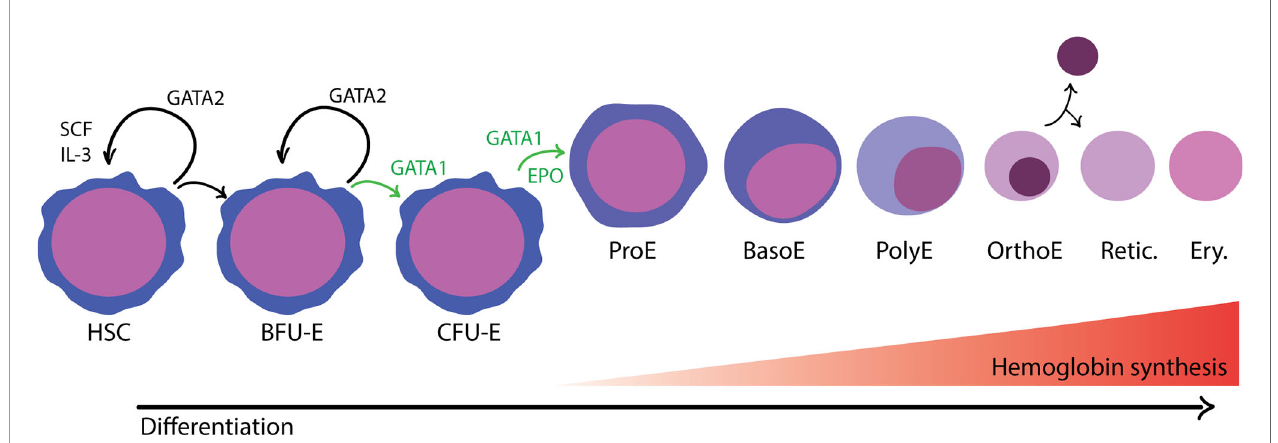
FIGURE 1 | Overview of adult, de fi nitive erythropoiesis in the bone marrow. The bone marrow is populated with hematopoietic stem cells with the capacity for long-term self-renewal and the potential to differentiate down any of the blood cell lineages. The balance between self-renewal and lineage commitment is informed by physical and chemical signals present in the surrounding microenvironment and coordinated by master transcription factors. Erythroid commitment is largely controlled by the activity of GATA1, which promotes differentiation and inhibits opposing factors for self-renewal, such as GATA2. In the fi rst phase of development, progenitor cells become gradually more erythroid committed in response to environmental cues that promote proliferation and differentiation. Burst forming unit-erythroid (BFU-E) are considered the fi rst irreversibly committed erythroid cells. In the subsequent stage, colony forming unit-erythroid (CFU-E) cells are highly proliferative and begin to activate erythroid transcriptional programs regulated by GATA1, in response to erythropoietin (EPO). In the terminal differentiation phase, erythroblasts develop in a specialized compartments called erythroblastic islands. Erythroblasts are found in close association with a central macrophage that provides signals to support proliferation and differentiation as well as the iron needed for hemoglobin synthesis. As erythroblasts differentiate, they decrease in size, undergo nuclear condensation, and turn off gene expression with the exception of a subset of erythroid-speci fi c genes, most notably hemoglobin. Distinct morphological stages are visible by hematological staining: proerythroblast (ProE), basophilic erythroblast (BasE), polychromatic erythroblast (PolyE), and orthochromatic erythroblast (OrthoE). In the fi nal stage of development, the nucleus and organelles are extruded. The enucleated reticulocyte (Retic.) undergoes further development as it enters circulation, eventually becoming a mature erythrocyte